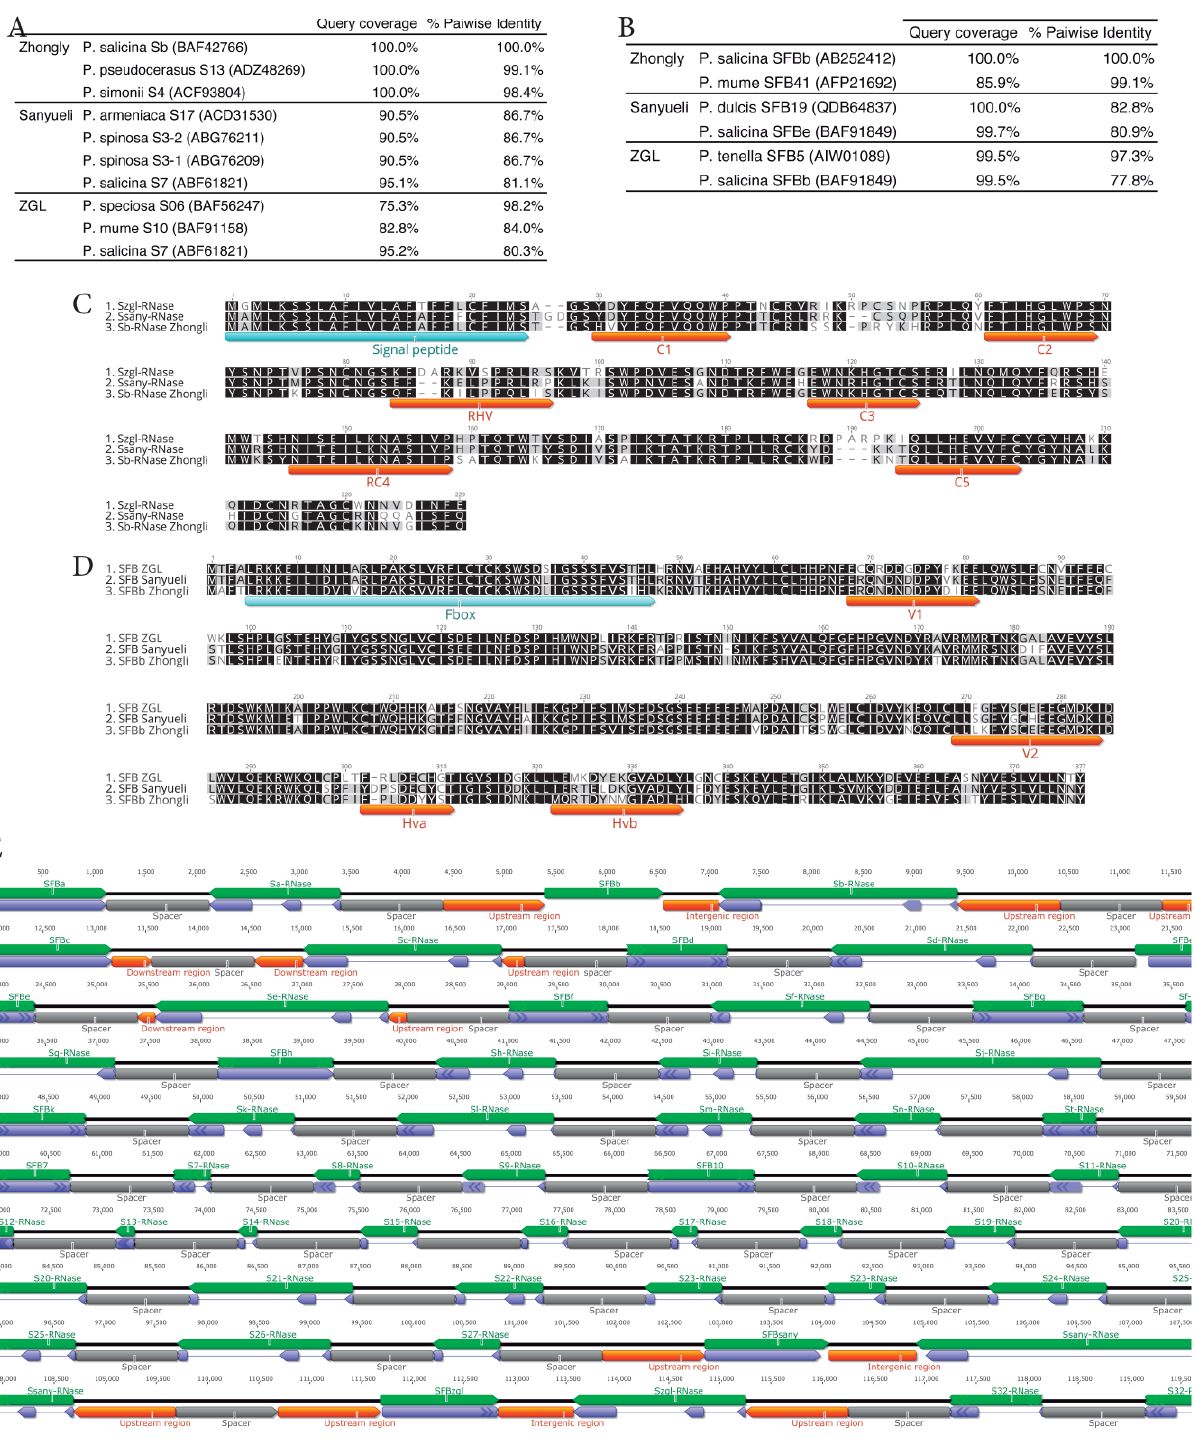
Figure 1. Full S -loci sequences retrieved from published reference genomes and synthetic reference sequence structure. ( A , B ) Pairwise trans-specific identities of the 6 retrieved S-RNase and SFB alleles. ( C ) Comparison of the amino-acids predicted from the coding regions of the three S-RNases. Signal peptide, conserved regions, and hypervariable regions (as defined by [66]) are highlighted. ( D ) Comparison of the amino acids predicted from the coding regions of the three SFBs. F-box, variable, and hypervariable regions (as defined by [47]) are highlighted. The amino acids of the S-RNases and SFBs were aligned using Muscle5 [67]. ( E ) Structure of the synthetic reference sequence used for aligning resequenced individuals. Genes (green), CDSs (blue), upstream, intergenic, and down- stream regions (orange), and 1000 bp spacers (grey) and their orientation are illustrated. Sizes of the boxes are proportional to sequence length. Accession numbers of the sequences of each allele are